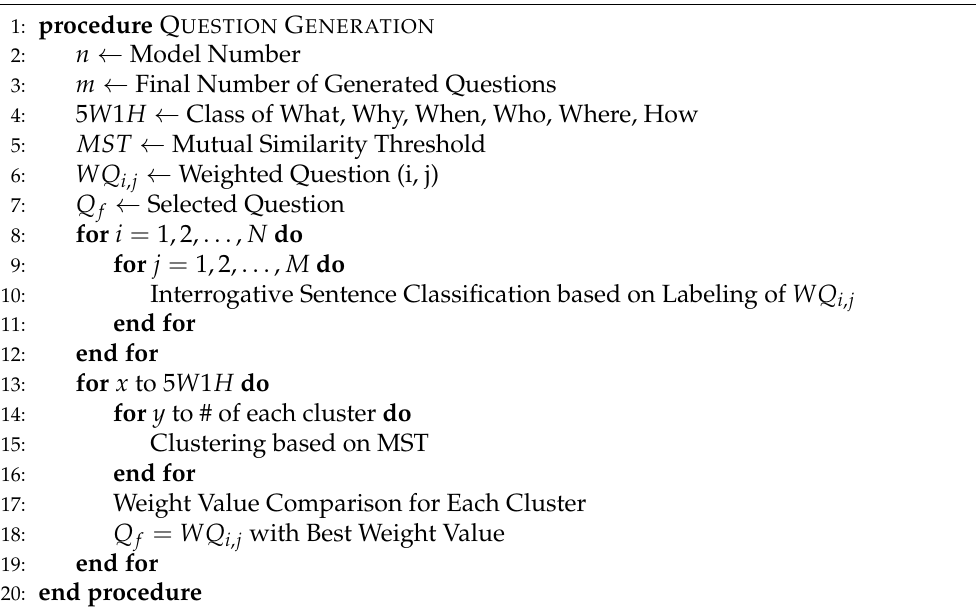
Algorithm 1 Soft-Voting Classifier of